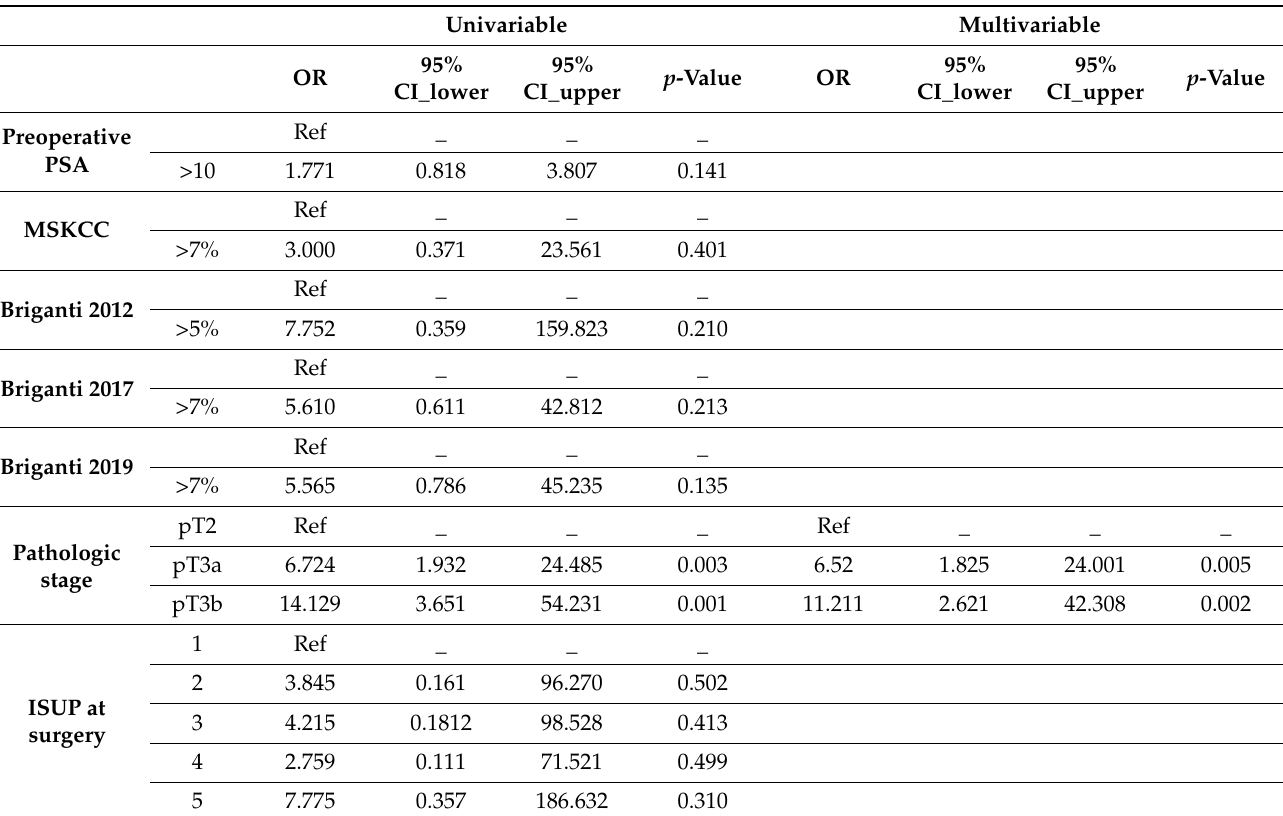
Odds Ratio (OR), 95% Confidential Interval (CI).